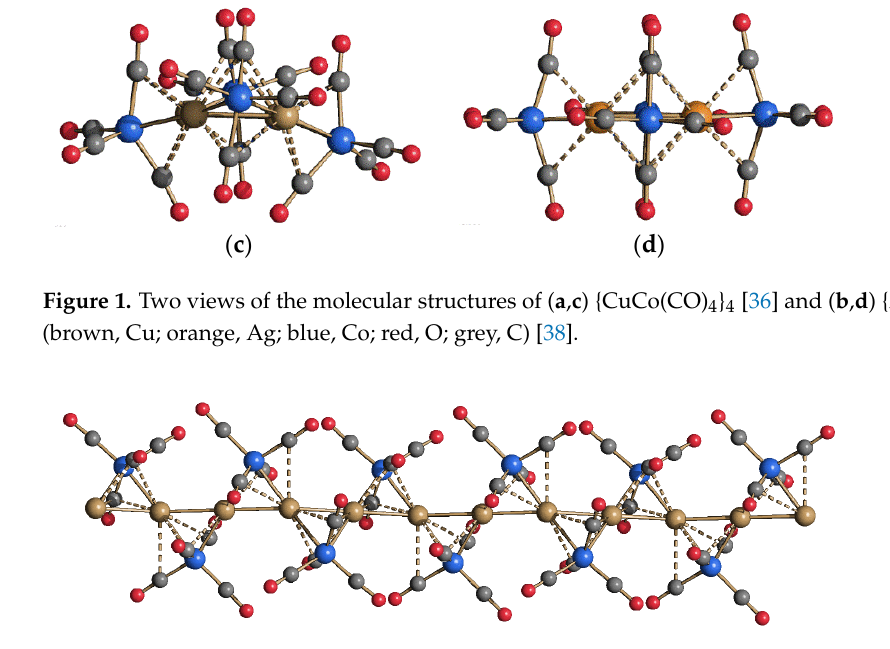
Figure 2. The molecular structure {CuCo(CO) 4 } ∞ (brown, Cu; blue, Co; red, O; grey, C) [37].